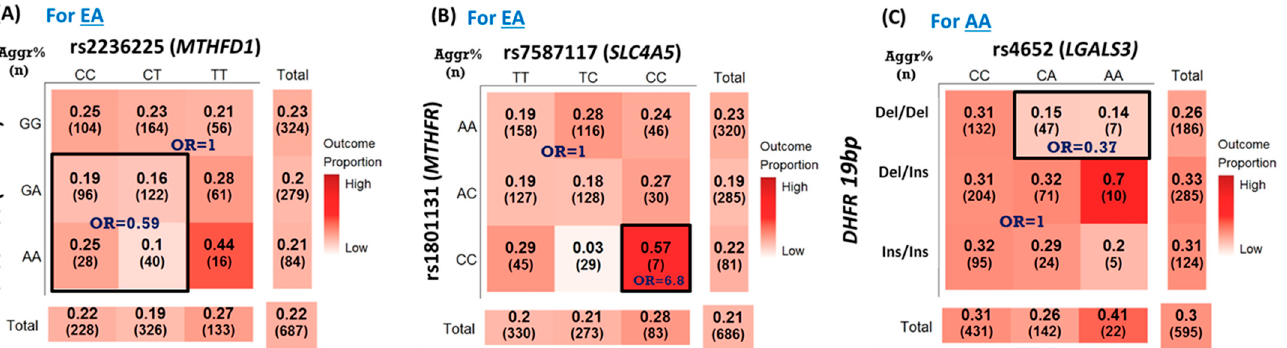
1 Odds ratio (95% confidence interval), logistic models adjusted for age, study site, and ancestry for the African population. 2 The percentage of significance, which was defined as p -interaction < 0.01 and p -interaction< p -value of any of the two composite SNPs, based on the bootstrap validation with 500 runs.